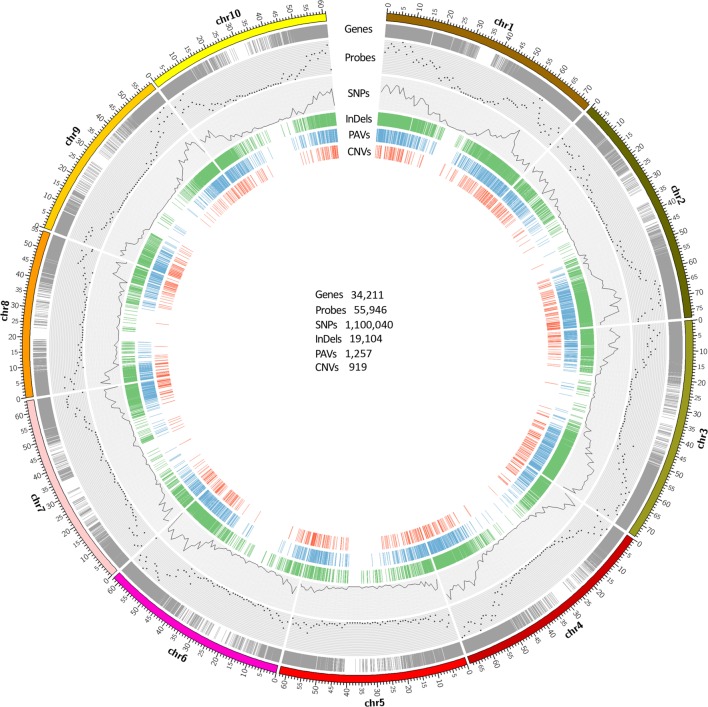
Genome-wide distribution of probes and sequence variants along sorghum genome. Gene models are displayed by gray ring showing the majority of gene regions on the chromosome arms. Scatter plot represents the number of probes within 1 Mb window size across sorghum genome. The SNPs for 12 accessions are plotted by the black line which represents the SNP density within 1 Mb window size across sorghum genome. The green color represents concordant InDels which were called by Samtools, GATK, and Freebayes. The blue and red color represent copy number variations, and presence and absence of variations identified in this study respectively. The number of gene models and each variant category are shownaren in the circle.